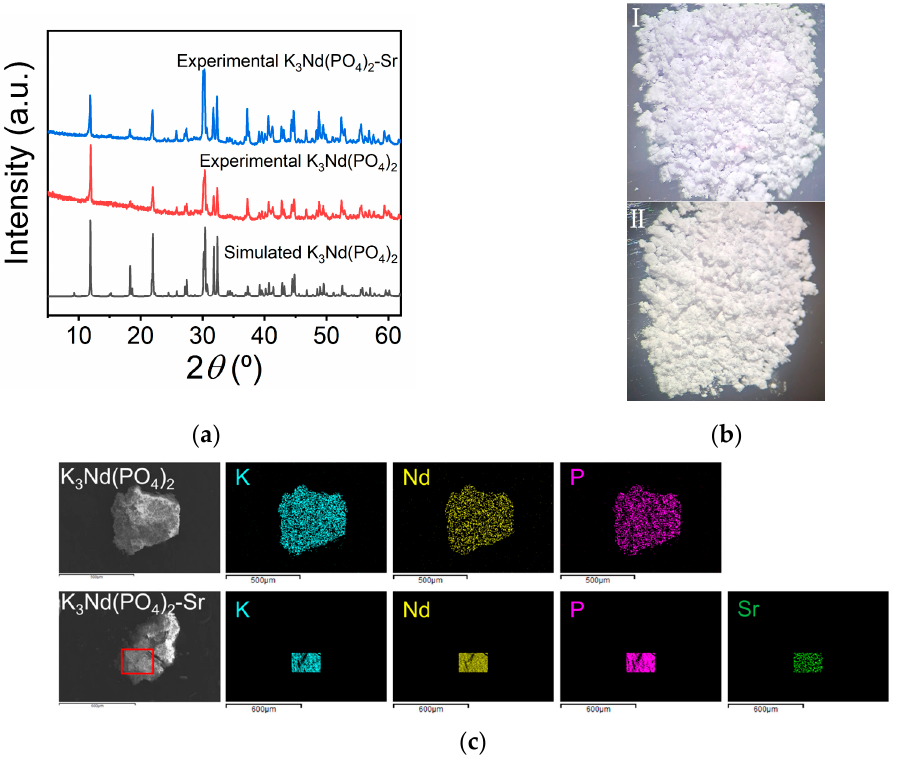
Figure 4. ( a ) Simulated and experimental PXRD diagrams of K 3 Nd(PO 4 ) 2 ; ( b ) photographs of powder samples for K 3 Nd(PO 4 ) 2 (I) and K 3 Nd(PO 4 ) 2 -Sr (II); ( c ) SEM of K 3 Nd(PO 4 ) 2 and K 3 Nd(PO 4 ) 2 -Sr and their elemental distribution maps of K, Nd, P, and Sr elements.